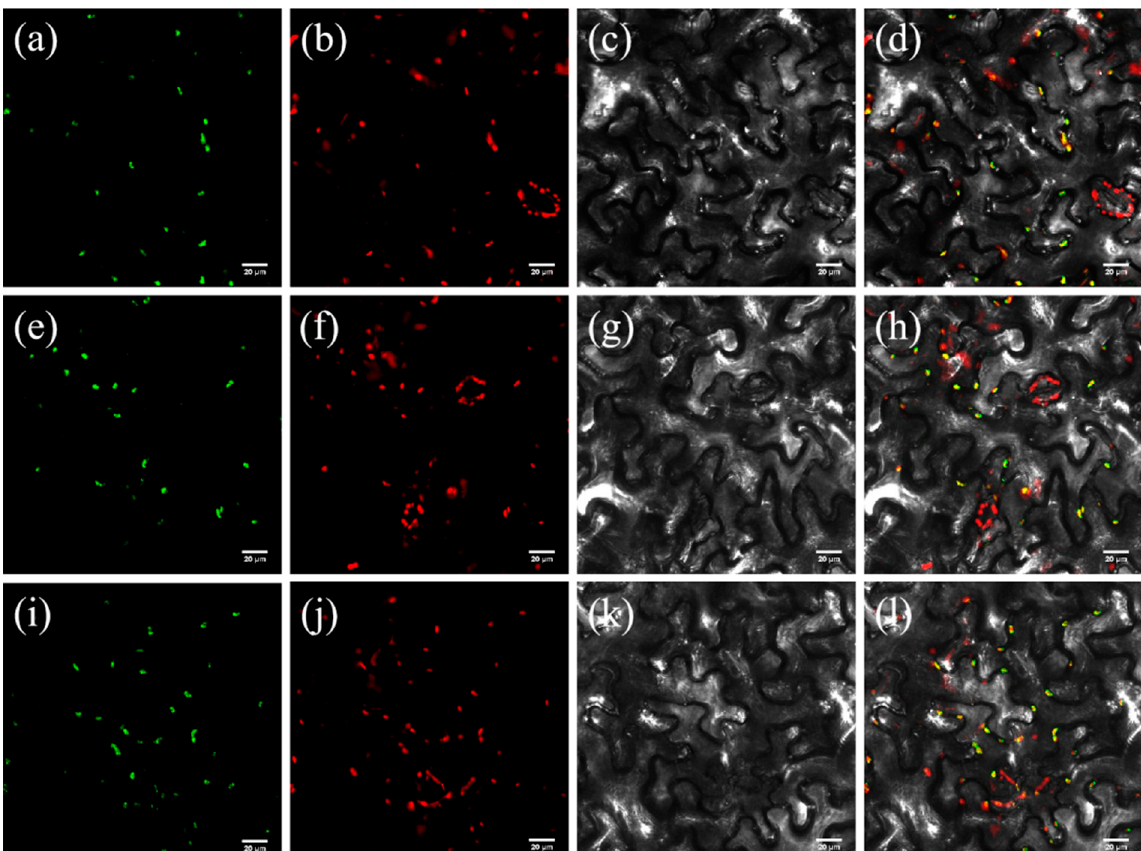
Figure 8. Subcellular localization of BoPSY proteins in tobacco leaf epidermis cells. ( a – d ) Subcellular localization of BoPSY.1. ( e – h ) Subcellular localization of BoPSY.2. ( i – l ) Subcellular localization of BoPSY.3. ( a , e , i ) Fluorescence signals of BoPSYs fused with GFP. ( b , f , j ) Fluorescence signal of chloroplast. ( c , g , k ) Bright field images. ( d , h , l ) Superposition images of bright field and fluorescence.